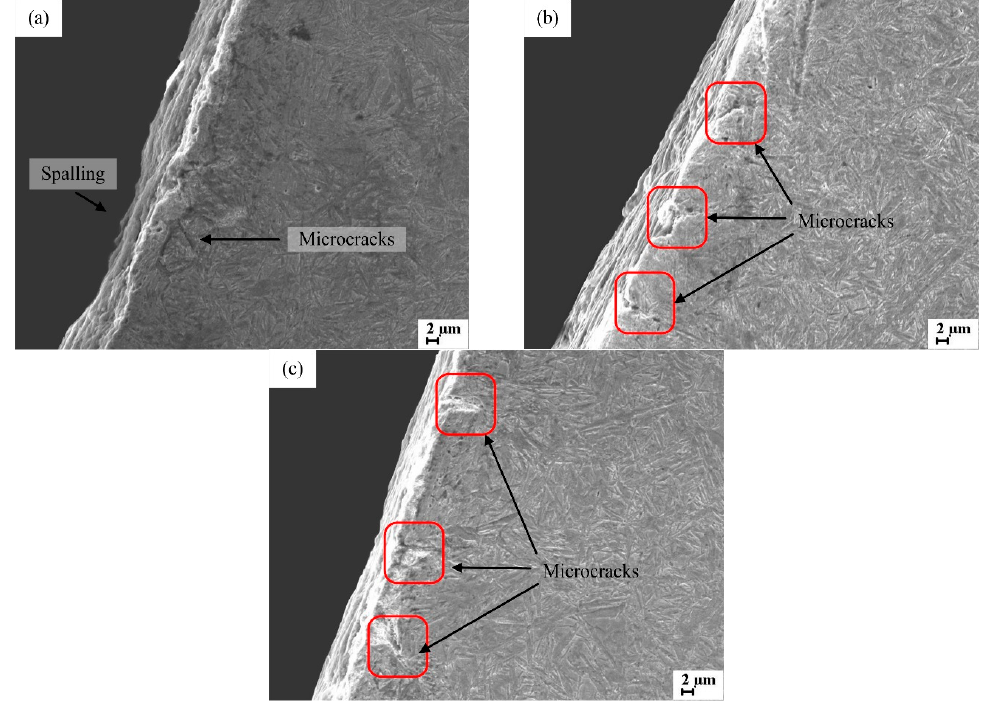
Figure 17. Microstructure of the zone near the tooth flank of gear 4 ‐ 2: ( a ) pitch point (V2, H5), ( b ) point (V2, H2), and ( c ) point (V2, H6).